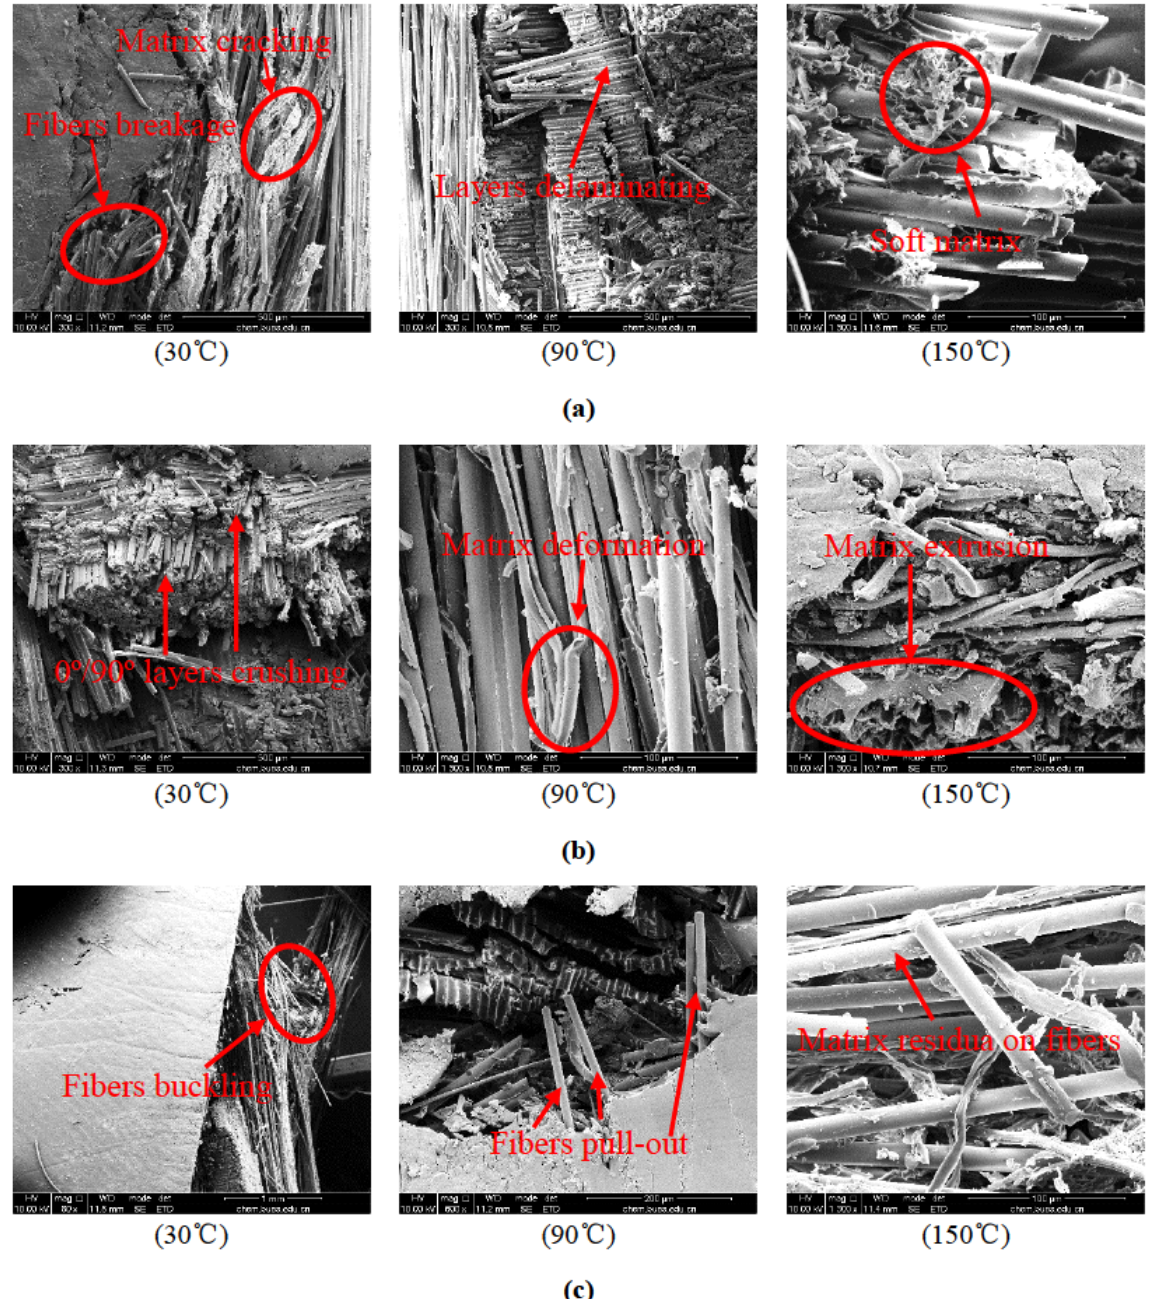
Figure 11: SEM photographs of out-of-plane compression fracture for three kinds of composites: (a) desized composite; (b) D 400 -GO-grafted composite; (c) GO-grafted composite